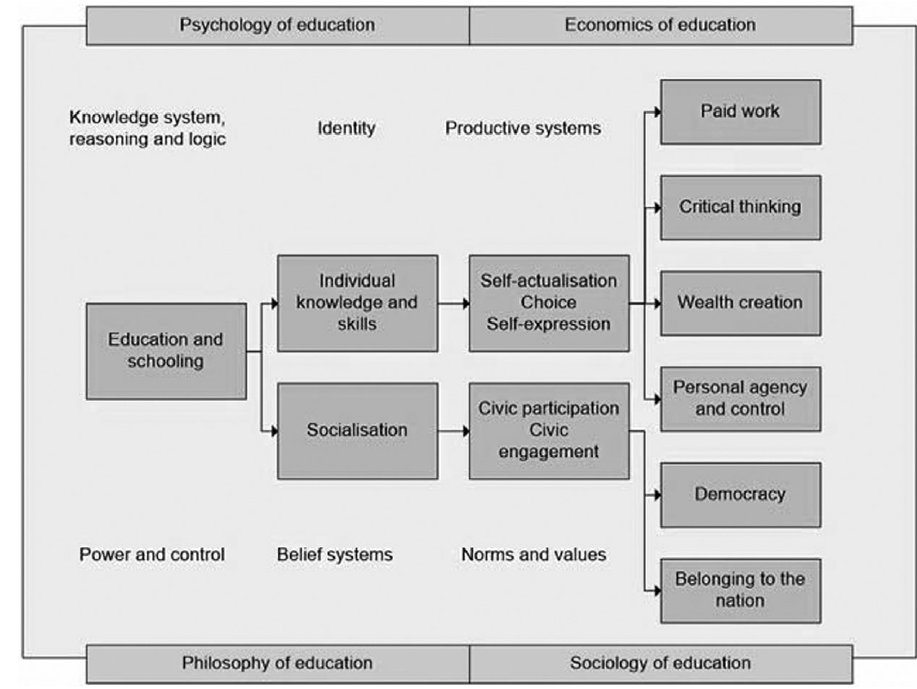
A frame of reference for advantage in the Australian education